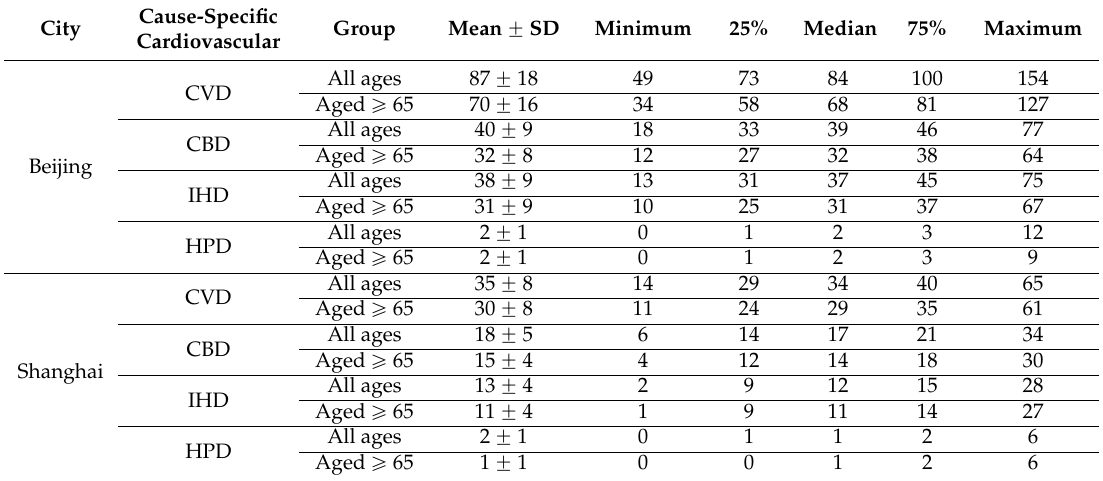
Table 1. Distribution of daily cause-specific cardiovascular mortality in Beijing and Shanghai, China, during 2007–2009. CVD, cardiovascular disease; CBD, cerebrovascular disease; IHD, ischemic heart disease; HPD, hypertensive disease.